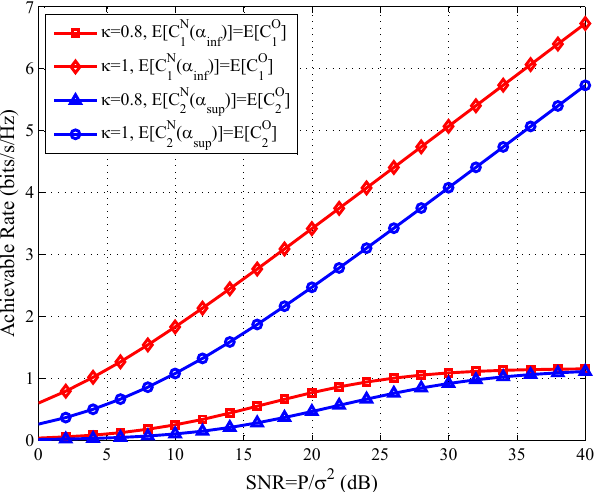
Figure 3. Comparing the capacity of OFDM-NOMA using fair power allocation approach vs.